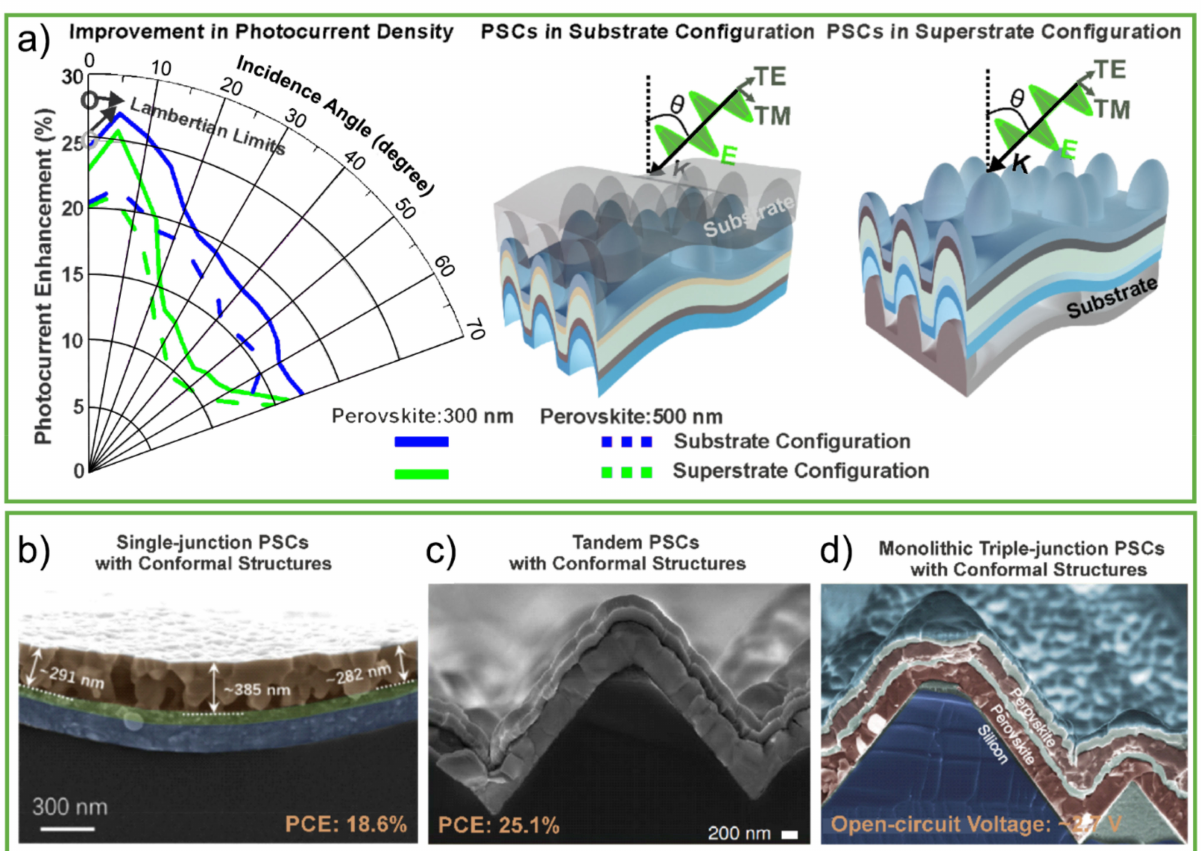
Figure 15. ( a ) The polar plot shows the photocurrent density gain as a function of the incidence angle ( θ ), attained with the optimized photonic-structured PSCs in a conformal architecture, for both the substrate and superstrate cell configurations illustrated in the middle and right sketches. The Lambertian limits of LT in PSCs, in the geometrical optics regime, are also indicated for normal incidence angle ( θ = 0 ◦ ) in the left plot. Adapted with permission from [30]. Copyright 2021 Elsevier. ( b ) SEM image of a single-junction PSC conformally coated onto a textured glass substrate. Adapted with permission from [168]. Copyright 2021 Elsevier. ( c ) SEM image of a tandem perovskite/silicon cell with ~25.1% efficiency, in which the PSC is conformally coated onto the textured silicon wafer-based bottom cell [169]. ( d ) SEM image of a triple-junction perovskite/perovskite/silicon cell in which the top and middle PSCs are also conformally deposited onto textured silicon. Adapted with permission from [170]. Copyright 2021 American Chemical